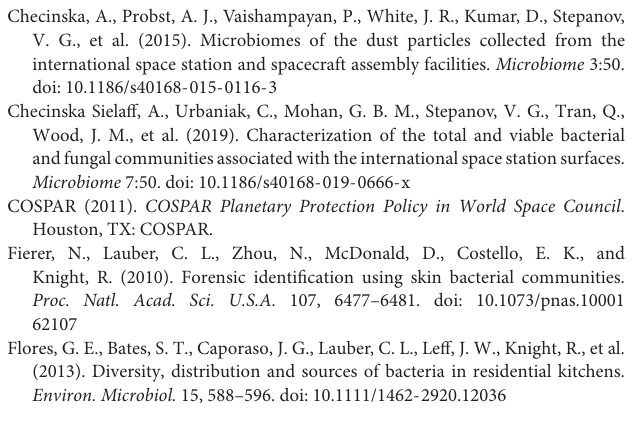
Supplementary Figure 1 | Total and Intracellular ATP measured in field control (FC) and surface samples collected from CRV1 and CRV2. Supplementary Figure 2 | Number of copies of (A) bacterial 16S and (B) fungal ITS detected via qPCR in CRV1 and CRV2 samples with and without PMA treatment. Field controls (FC), no template controls (NTC), extraction controls (Maxwell controls; MC), and positive controls (PC) are included for comparison. Supplementary Figure 3 | Relative abundance of domain based on shotgun metagenomic reads generated from PMA treated samples collected from three sampling events on the ISS and the internal (I) and ground support equipment (G) surfaces of CRV1 and CRV2. Supplementary Figure 4 | Relative abundance of phyla based on shotgun metagenomic reads generated from PMA treated samples collected from three sampling events on the ISS and the internal (I) and ground support equipment (G) surfaces of CRV1 and CRV2. Supplementary Figure 5 | Relative abundance of classes based on shotgun metagenomic reads generated from PMA treated samples collected from three sampling events on the ISS and the internal (I) and ground support equipment (G) surfaces of CRV1 and CRV2. Supplementary Figure 6 | Relative abundance of orders based on shotgun metagenomic reads generated from PMA treated samples collected from three sampling events on the ISS and the internal (I) and ground support equipment (G) surfaces of CRV1 and CRV2. Supplementary Figure 7 | Relative abundance of families based on shotgun metagenomic reads generated from PMA treated samples collected from three sampling events on the ISS and the internal (I) ground support equipment (G) surfaces of CRV1 and CRV2. Supplementary Figure 8 | Relative abundance of genera based on shotgun metagenomic reads generated from PMA treated samples collected from three sampling events on the ISS and the internal (I) and ground support equipment (G) surfaces of CRV1 and